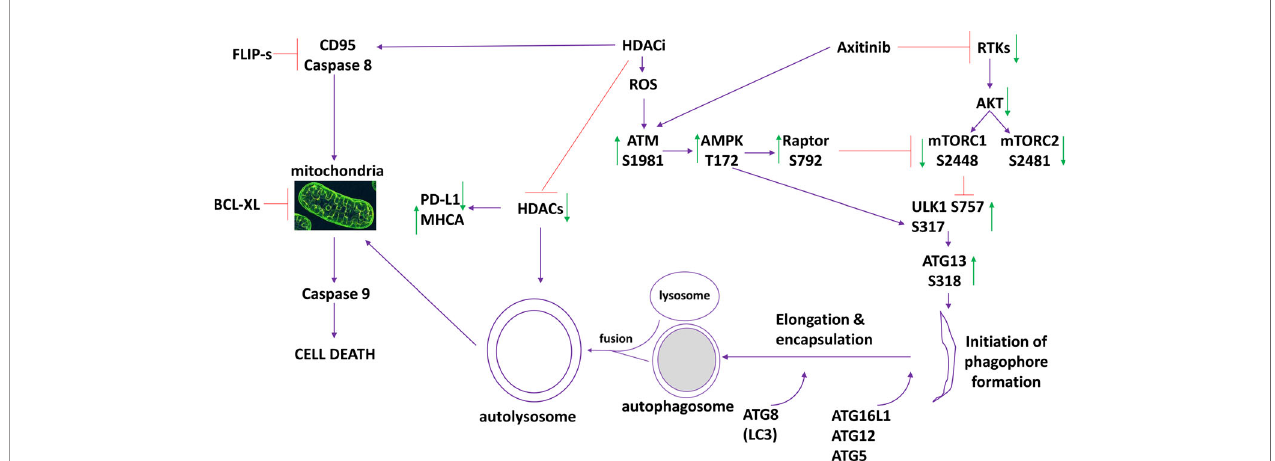
FIGURE 7 | The molecular mechanisms by which axitinib and HDAC inhibitors interact to kill sarcoma cells. Axitinib inactivates RTKs and downstream AKT/mTOR signaling is reduced. Axitinib and HDAC inhibitors both activate ATM. ATM activation results in activation of the AMPK and Raptor. This results in a greater inactivation of mTOR and complete activation of ULK1. ULK1 phosphorylates ATG13 which promotes autophagosome formation followed by autophagic fl ux and the formation of autolysosomes. HDAC proteins are inhibited by HDACi but these proteins are also digested in the autolysosomes reducing their total protein levels. This directly impacts upon the expression of PD-L1 (reduced) and MHCA (enhanced). HDACs can increase the expression and trimerization of the death receptor CD95. Inhibition of caspase 8/10 by FLIP-s signi fi cantly reduced cell killing. Autolysosome proteases such as cathepsins can cause mitochondrial dysfunction, as can caspase 8 signaling. Over-expression of the mitochondrial protective protein BCL-XL signi fi cantly reduced killing. Downstream of the mitochondrion, killing can be mediated by cytochrome c/caspase 9/caspases 3 and 7 or by AIF. Our data, by expressing dominant negative caspase 9, argues that the majority of the death signal is mediated via caspase 9/caspase